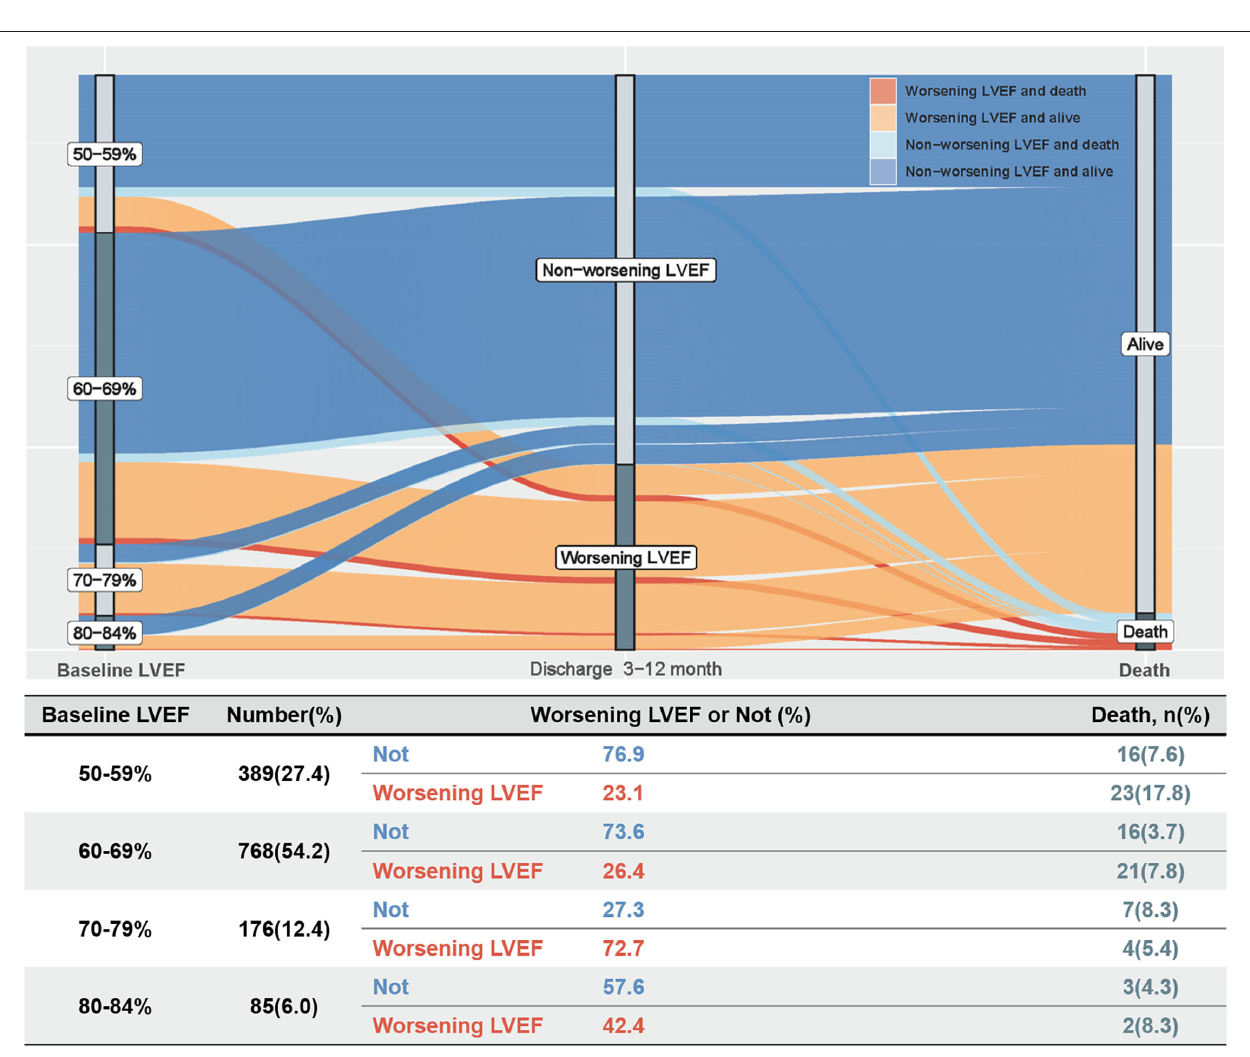
FIGURE 3 | The trajectory of worsening LVEF and eventual mortality in patients with